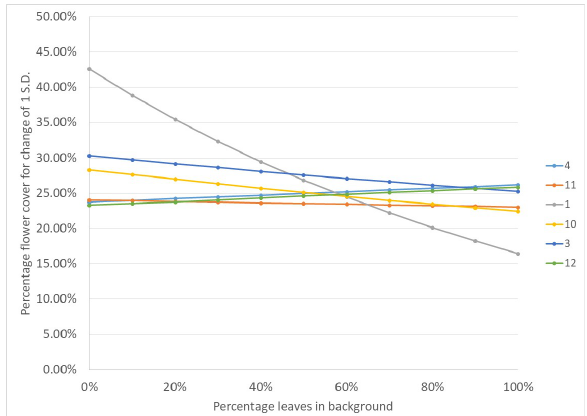
Figure 7. Percentage cover of flowers require to change the reflectance by 1 standard deviation for different background ratios of ground and leaves for MODIS bands